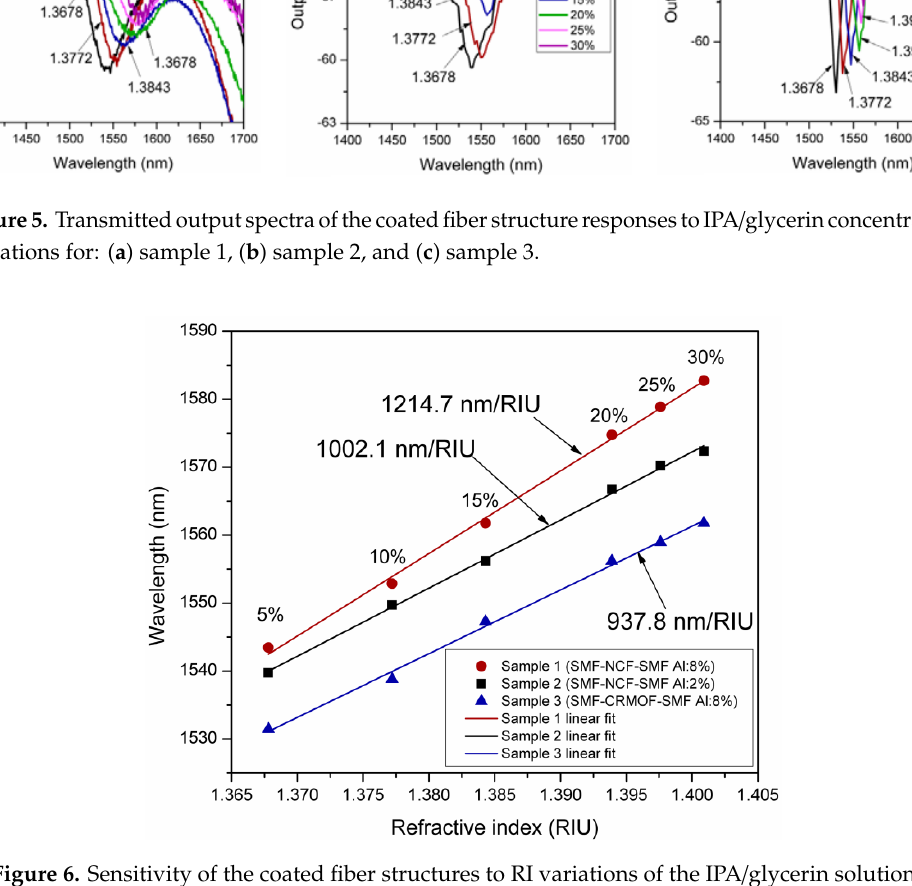
Figure 5. Transmitted output spectra of the coated fiber structure responses to IPA/glycerin concentration variations for: ( a ) sample 1, ( b ) sample 2, and ( c ) sample 3.